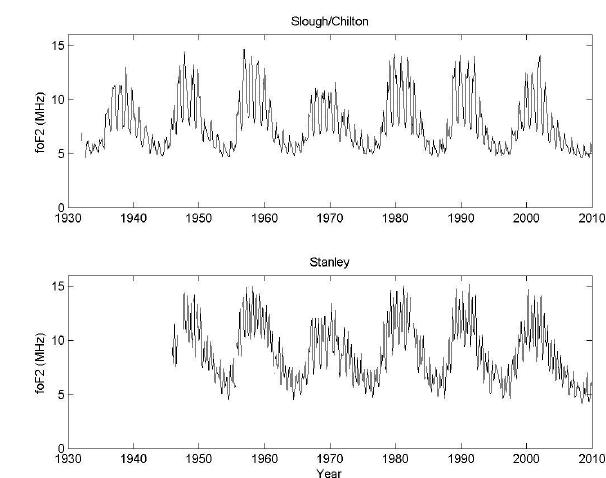
Fig. 1. Long-term variations in monthly median noon fo F2 for Figure 1. Long-term variations in monthly median noon foF2 for Slough/Chilton in the UK 2 Slough/Chilton in the UK (top panel) and Stanley in the Falkland (top panel) and Stanley in the Falkland Islands (lower panel). The ionosphere above both 3 Islands (lower panel). The ionosphere above both stations is modu- stations is modulated by the eleven year solar activity cycle. Superposed with this is a 4 lated by the eleven-year solar activity cycle. Superposed with this is dominant annual variation at Chilton and a semi-annual variation at Stanley.5 a dominant annual variation at Chilton and a semi-annual variation at